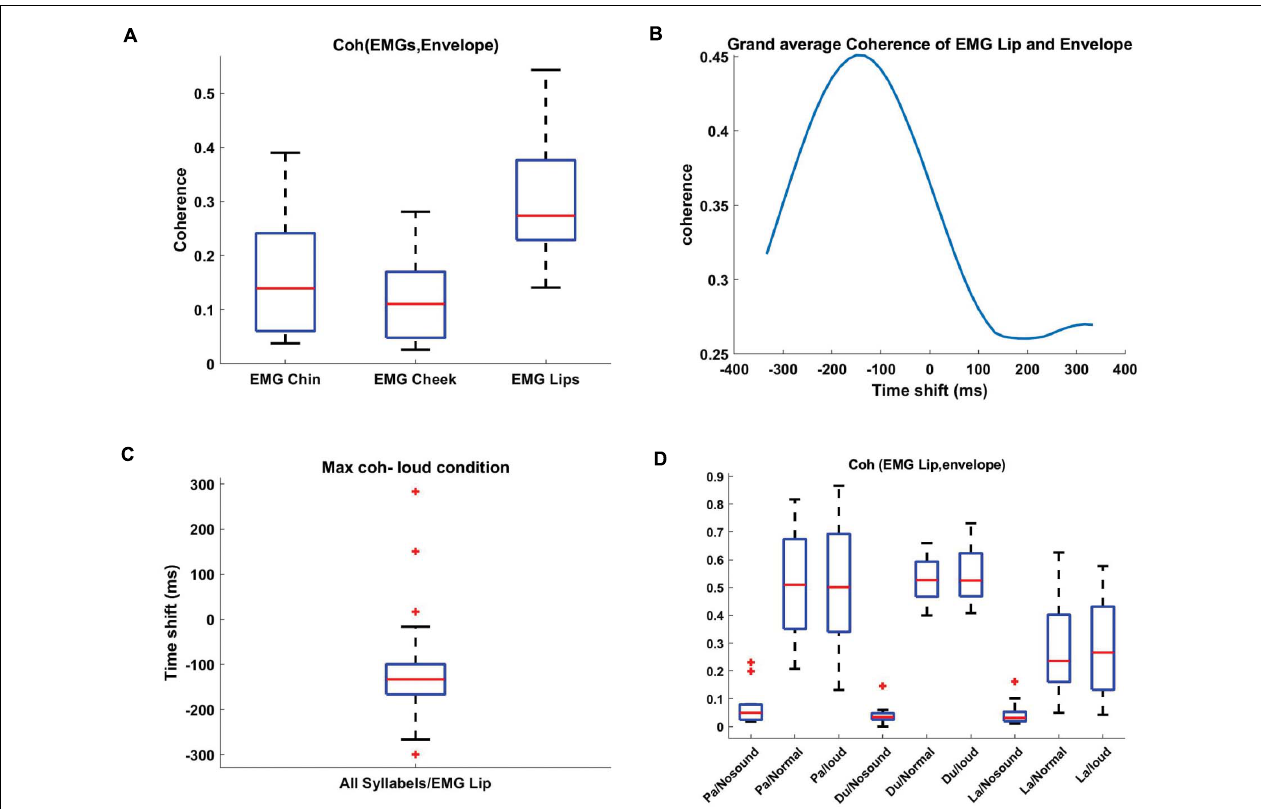
FIGURE 5 | Coherence between recorded EMG and speech envelope. (A) Boxplots showing the distribution of the coherence, between EMG signals and speech envelope, normalized by subtracting the No-sound condition from the loud condition and averaged across all syllables. EMG Lip signal displays the strongest coherence with the speech envelope signal. (B) Coherence was computed for each participant between the EMG signals and time-shifted speech envelope. These coherence values were subsequently averaged across all participants for each pair (EMG, Envelope) and each frequency. Finally, for each pair, the coherence values were averaged within the frequency range 0–5 Hz. The group results show the optimal temporal delay in –150 ms. (C) The distribution of optimal time-shifts leading to maximum coherence across participants. (D) Boxplots display the distribution of coherence between the shifted speech envelope (–150 ms) and EMG Lip for different syllables and loudness. For all the three syllables, normal and loud loudness caused stronger coherence in comparison to the No-sound